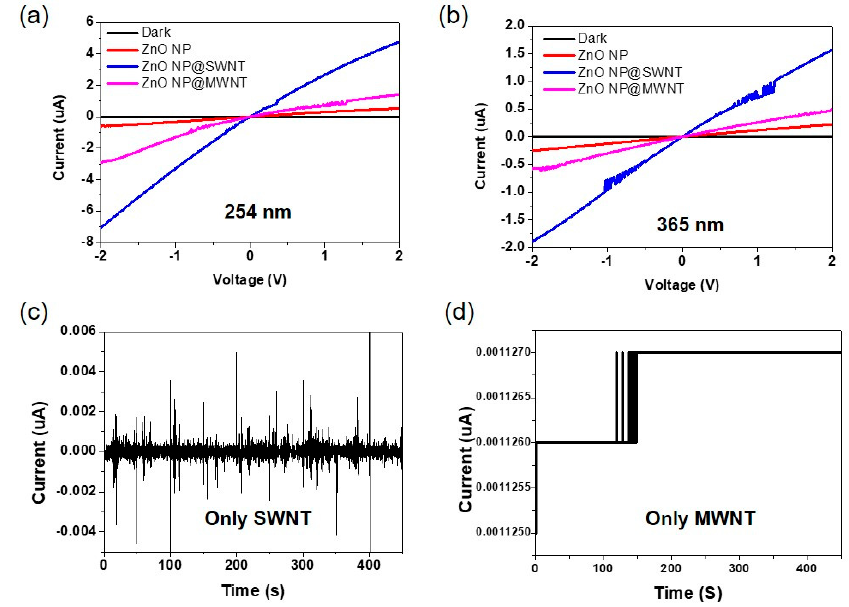
Figure 5. I–V curves of three different UV sensors (ZnO NPs, ZnO NP@SWNT, and ZnO NP@MWNT) under different wavelength UV irradiation ( a ) 254nm and ( b ) 365nm (1.25 mW/cm 2 ), and photoresponse of UV sensors made of ( c ) only A-SWNT and ( d ) MWNT.